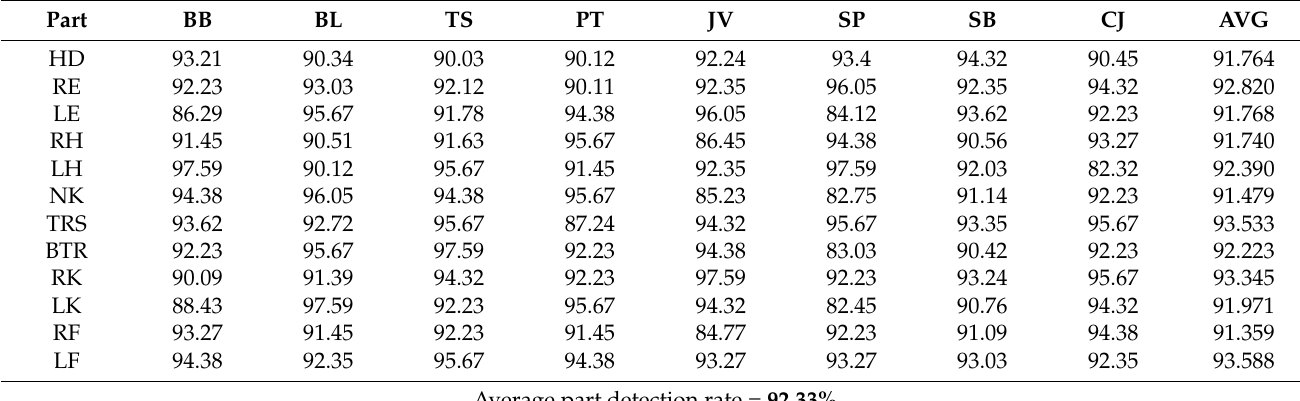
Table 5. Body part detection rate achieved over D3D-HOI dataset.